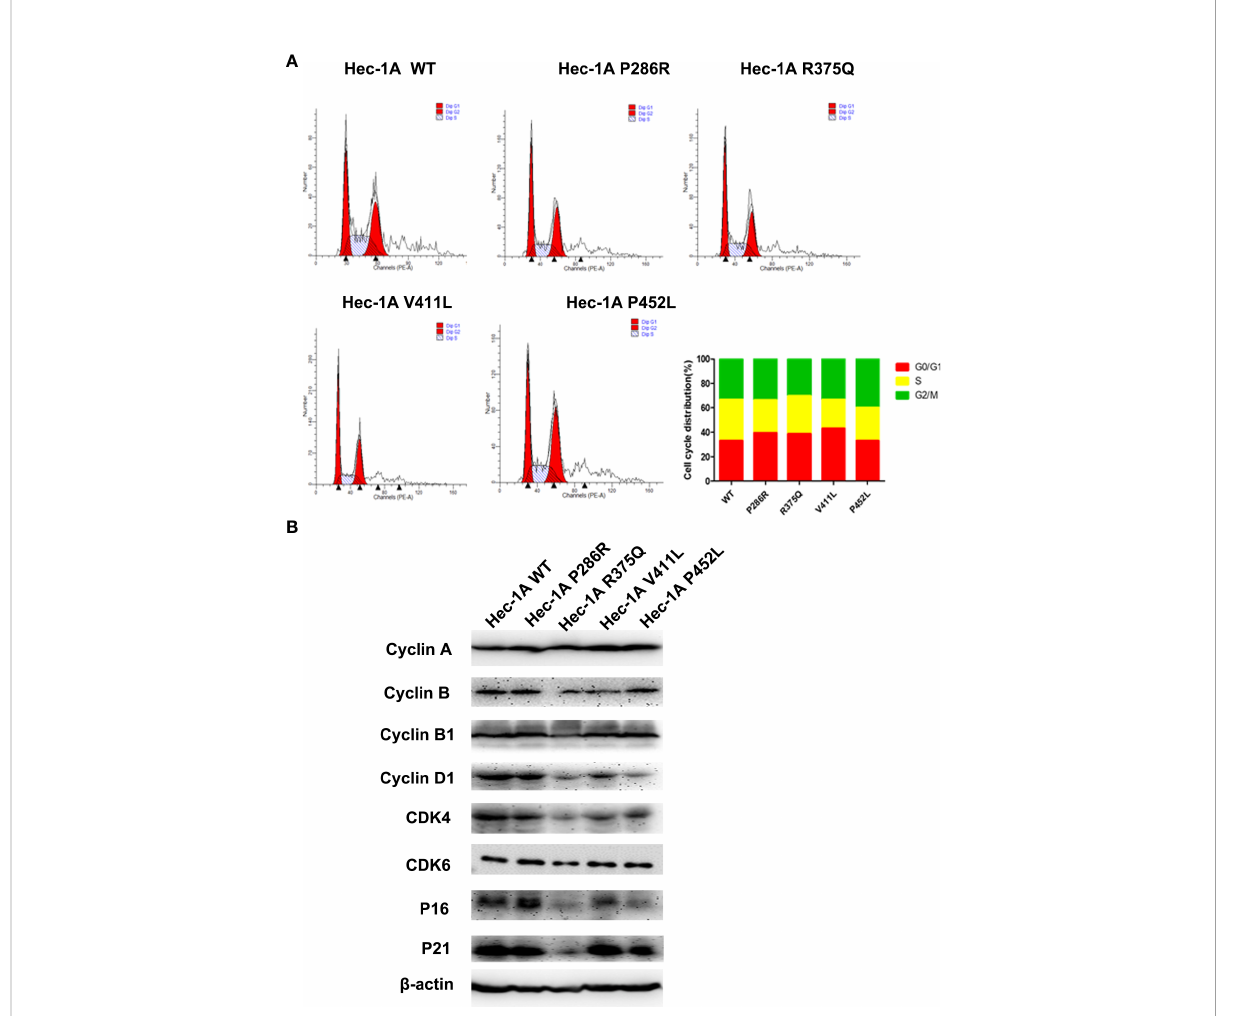
FIGURE 3 POLE EDMs induced G0/G1 cell cycle arrest in endometrial cancer cells. HEC-1A cells were transiently transfected with wildtype POLE or P286R, R375Q, V411L, or P452L variant. (A) Flow cytometry analysis was conducted at 48 h after transfection to analyze the cell cycle. (B) Western blot analysis was carried out at 48 h after transfection to measure the protein levels of Cyclin A, clyclin B, cyclin B1, cyclin D1, CDK4, CDK6, P16, and P21. b -actin was used as an internal reference. Data are expressed as the mean ±